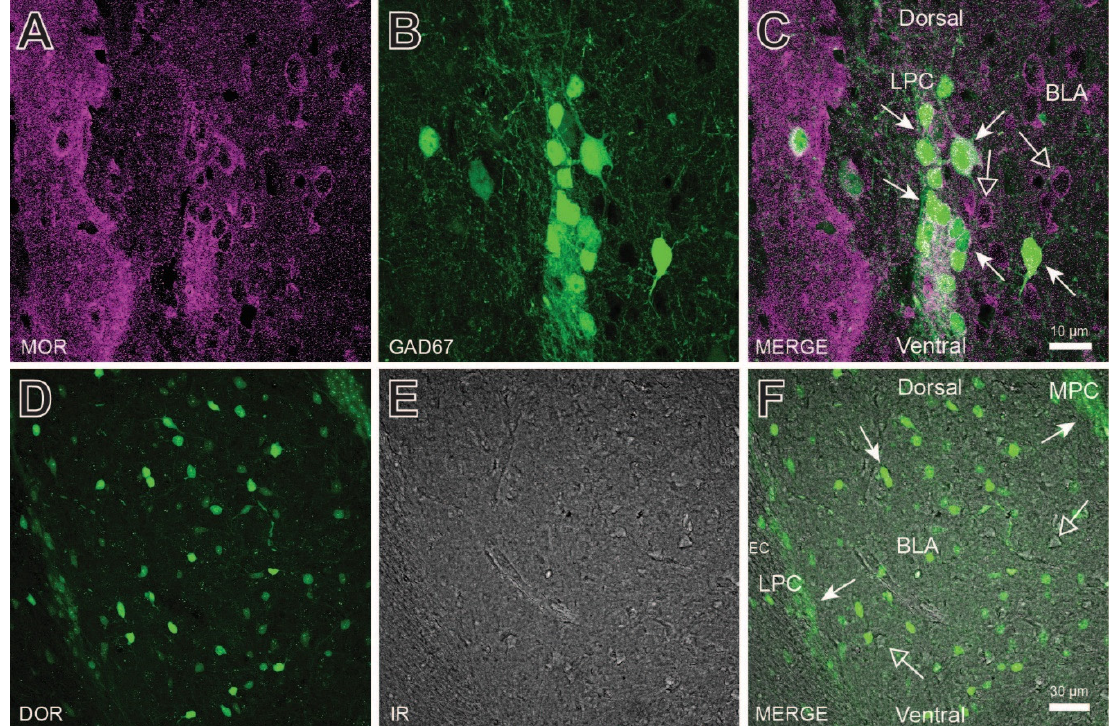
Figure 2. Opioid receptor expression in lateral paracapsular (LPC) neurons and throughout the basolateral amygdala (BLA). ( A – C ) mu-opioid receptor (MOR) antibody labeling of the LPC cluster and BLA in GABAergic (GAD67GFP+, closed arrows) and non-GABAergic (GAD67GFP-, open arrows) neurons. ( D – F ) Delta-opioid receptor (DOR) antibody labeling of the LPC and MPC clusters and BLA. DOR positive cells (closed arrows) were observed throughout the BLA, but are also surrounded by DOR negative cells (open arrows) as visualized using IR. Although MOR and DOR antibody labeling were concentrated in LPC and MPC clusters, both labels were observed to some degree throughout the BLA.